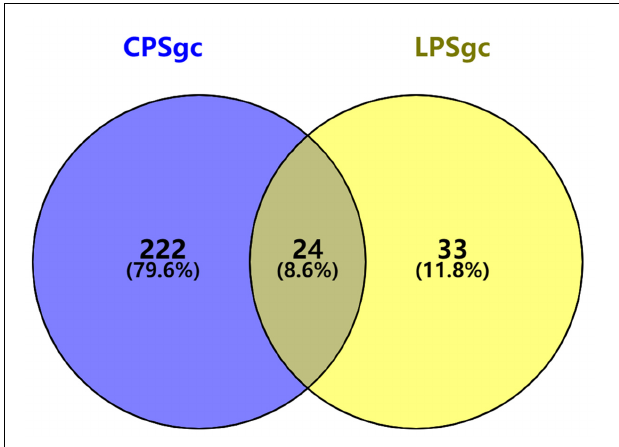
FIGURE 2 | Shared and unique gene orthogroups identified in gene clusters for lipopolysaccharide (LPSgc) and gene clusters for capsular polysaccharide